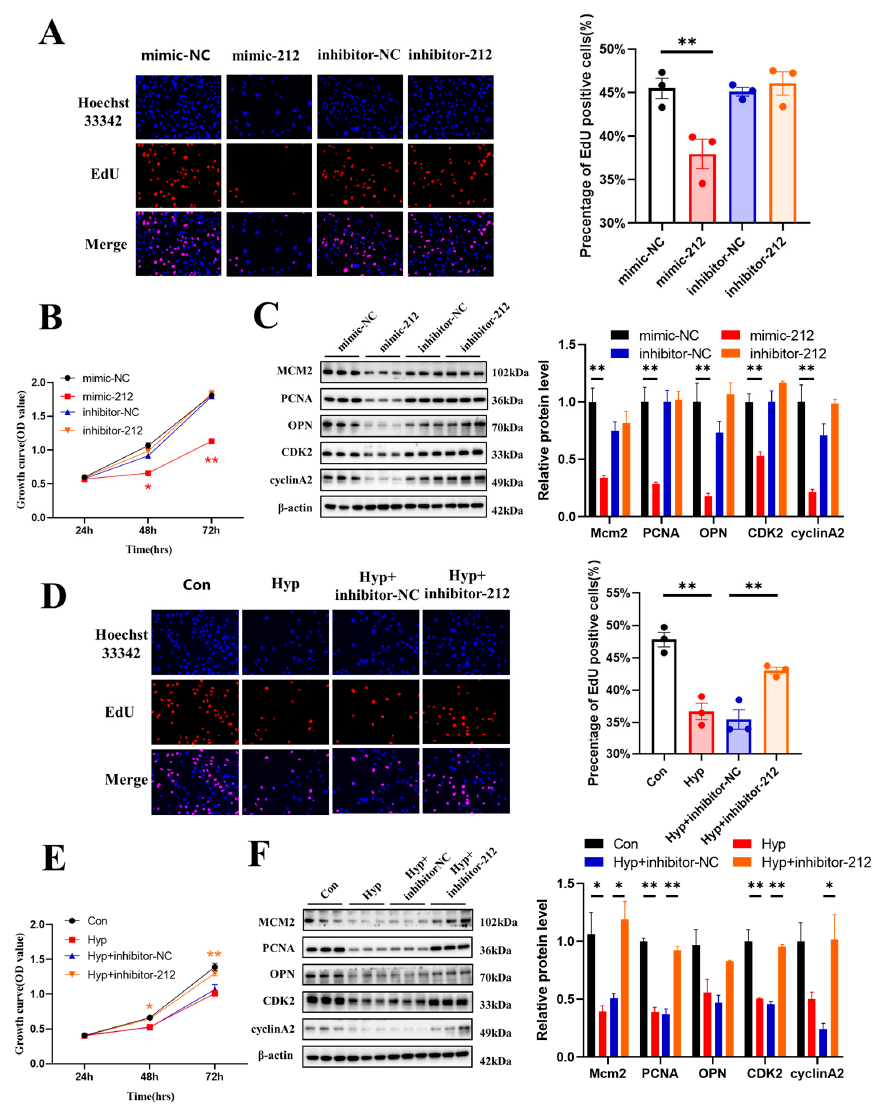
Figure 6. miR-212-3p inhibitor attenuates the inhibition of cell cycle progression and cell prolifera- tion caused by hypoxia. ( A ) The EdU (red) assay was used to examine cell proliferation ( n = 3). EVOS M5000 objective magnification: 20×. ( B ) Cell proliferation was evaluated by a CCK-8 assay ( n = 3). The symbol * (red) represents the mimic-212 vs. mimic-NC group. ( C ) Western blot analysis of MCM2, PCNA, OPN, CDK2, and cyclin A2 ( n = 3). ( D ) The EdU (red) assay was used to examine cell proliferation ( n = 3). EVOS M5000 objective magnification: 20×. ( E ) Cell proliferation was evalu- ated by a CCK-8 assay ( n = 3). The symbol * (orange) represents Hyp + inhibitor-NC vs. Hyp + in- hibitor-212. ( F ) Western blot analysis of MCM2, PCNA, OPN, CDK2, and cyclin A2 ( n = 3). Data are shown as the mean ± SEM, * p < 0.05, ** p < 0.01.